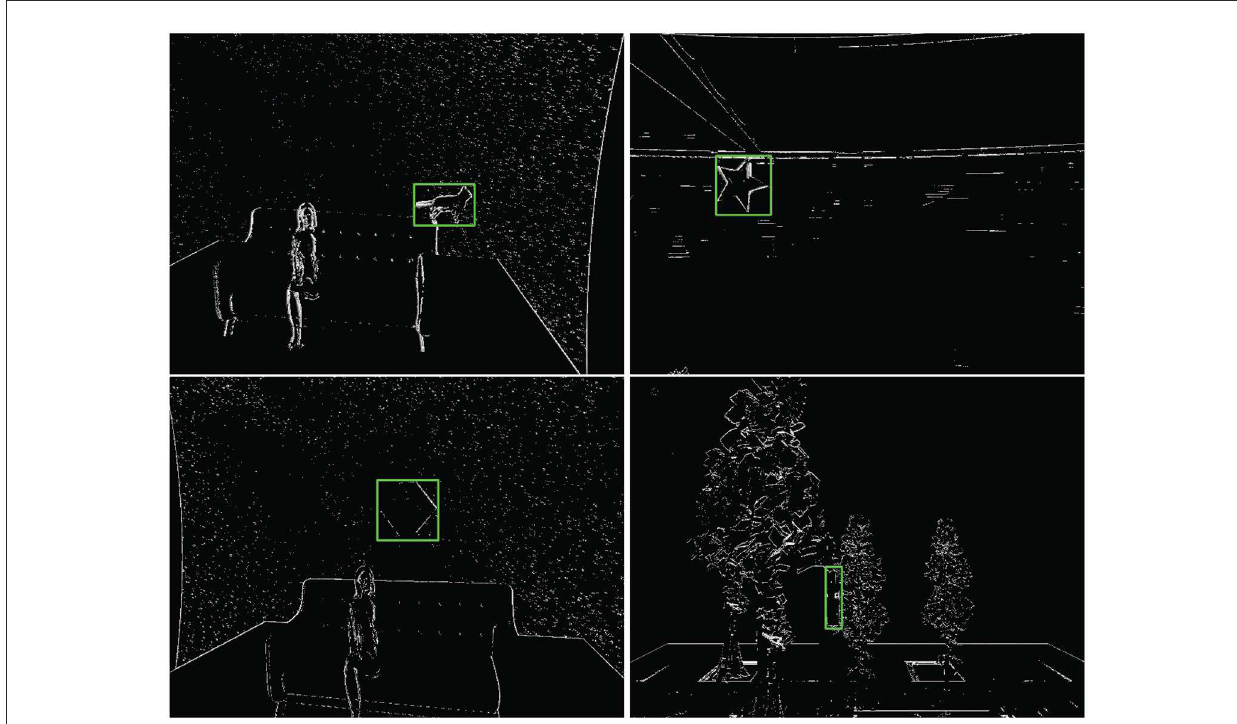
FIGURE5 The first segment of four sequences in the DVSOT21 training set, where the green bounding boxes represent the corresponding ground-truths. From left to right and from top to bottom, the sequences are woman _ cat , trees _ star , woman _ cube and trees _ bottle respectively.